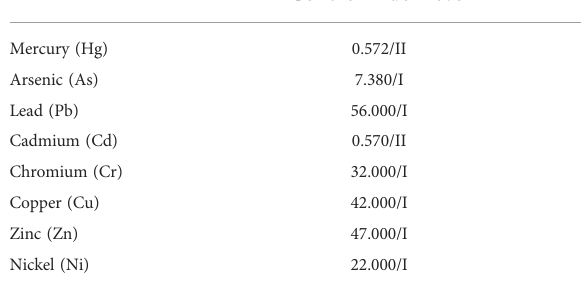
TABLE 2 Heavy-metal content and index grade of raw